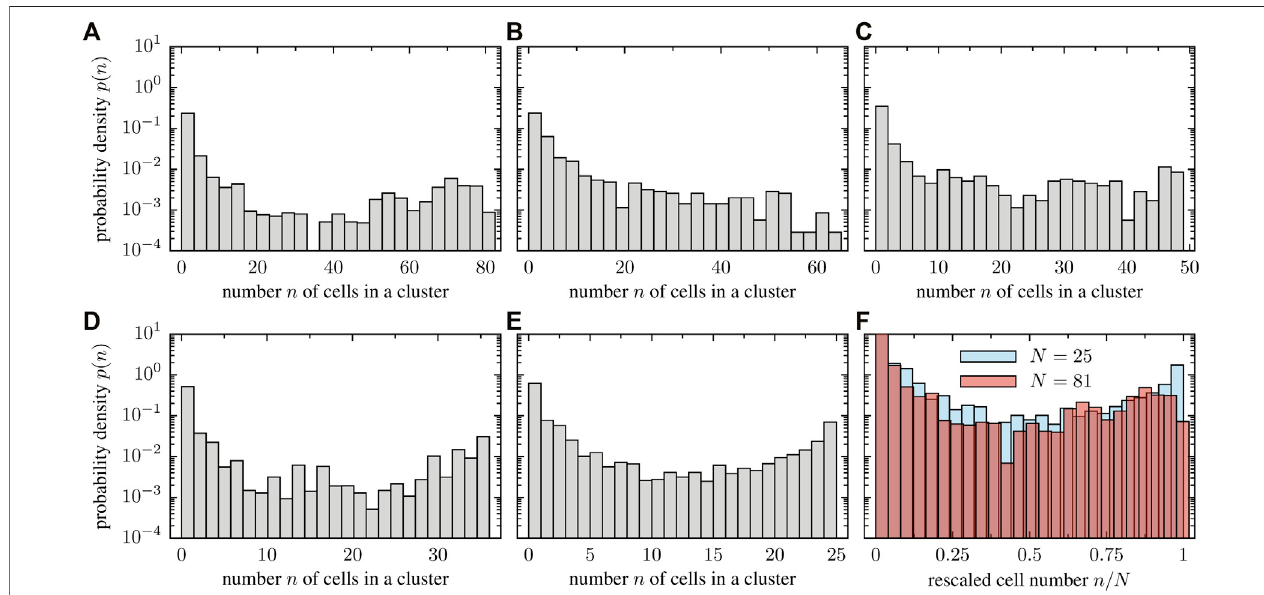
FIGURE 12 | Cluster size distribution for a fi xed packing fraction but various system sizes: (A) 81 cells and L = 108 μ m , (B) 64 cells and L = 96 μ m , (C) 49 cells and L = 84 μ m , (D) 36 cells and L = 72 μ m , (E) 25 cells and L = 60 μ m . In panel (F) , we overlay the probability distribution of the rescaled cluster size n / N for the smallest and largest particle number, indicating that the structure of the cluster size distribution is system size